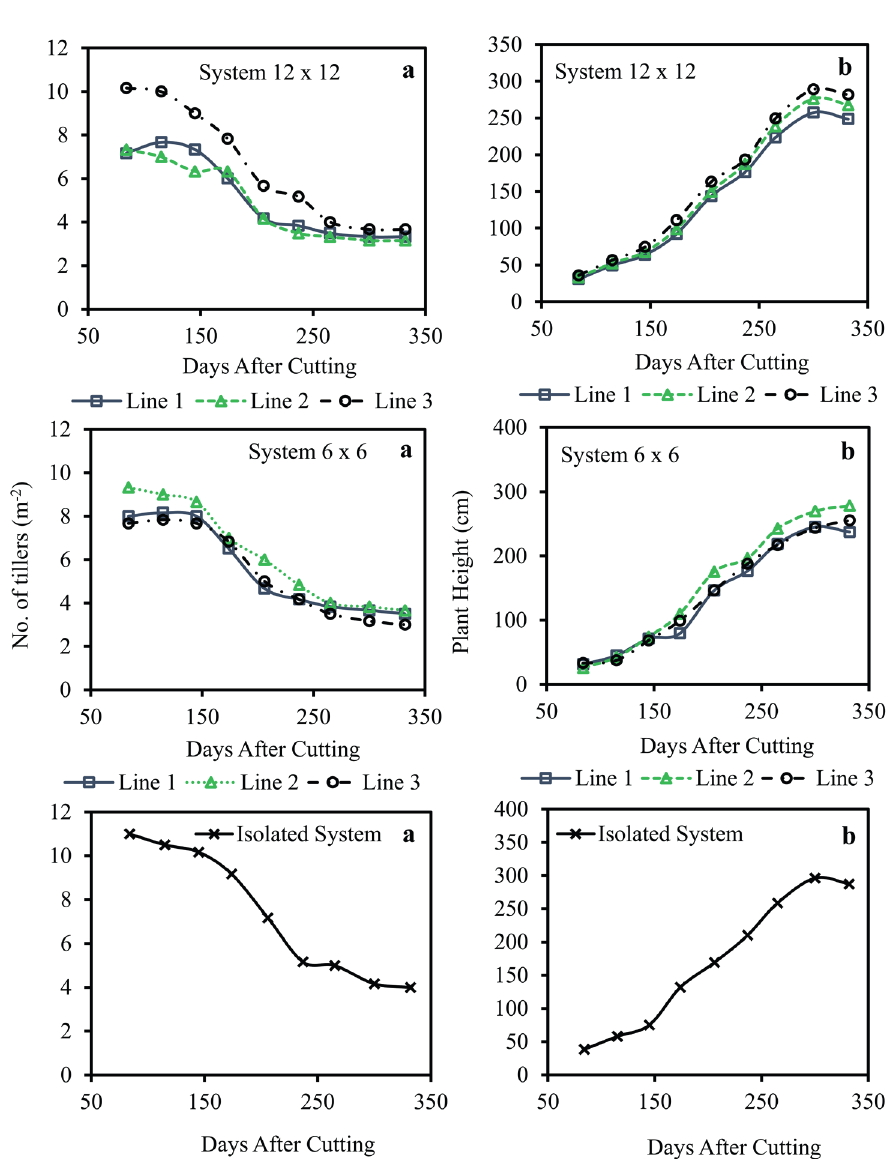
Figure 6 - Number of tillers ( a ) and plant height ( b ) of sugarcane in agroforestry and isolated systems in different lines of evaluation throughout the days after